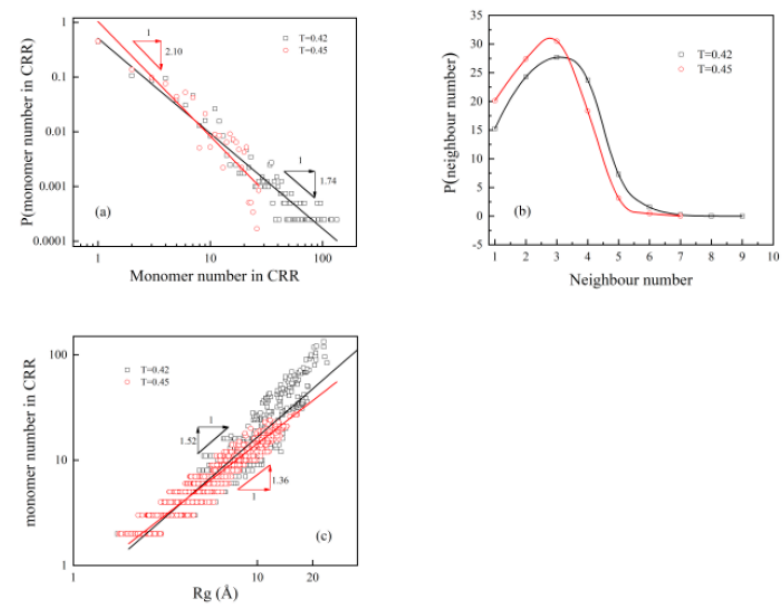
Figure 8. Size and shape of CRRs. ( a ) Number of monomer distribution of sting-like CRRs. The lines are the best fit, with a slope of 2.10 at T = 0.45 and 1.74 at T = 0.42. ( b ) Distribution of the number of neighbors in the CRR. It has an average of 2.5 nearest neighbors at T = 0.45 and 3.0 nearest neighbors at T = 0.42. ( c ) The radius of gyration dependence of CRR cluster weight. The best fit shows the fractal dimension of the CRR, i.e., 1.36 at T = 0.45 and 1.52 at T = 0.42.